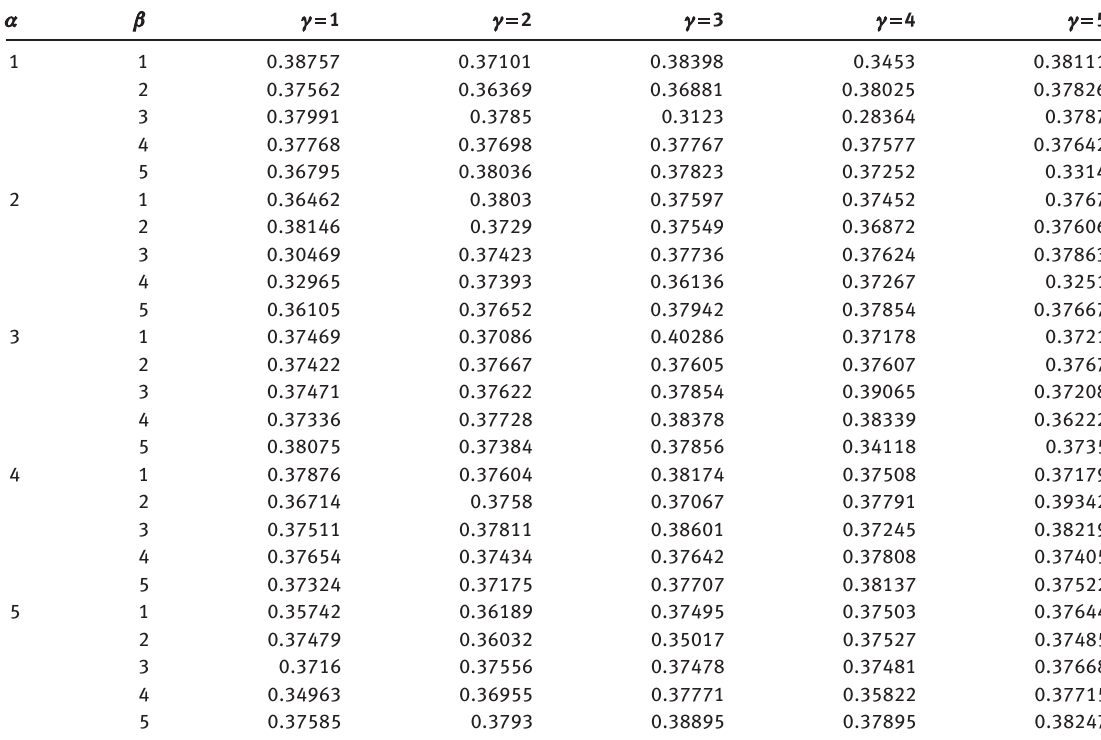
Table 4: Parameters used in Temperature under Varying β and γ with the Reference of α